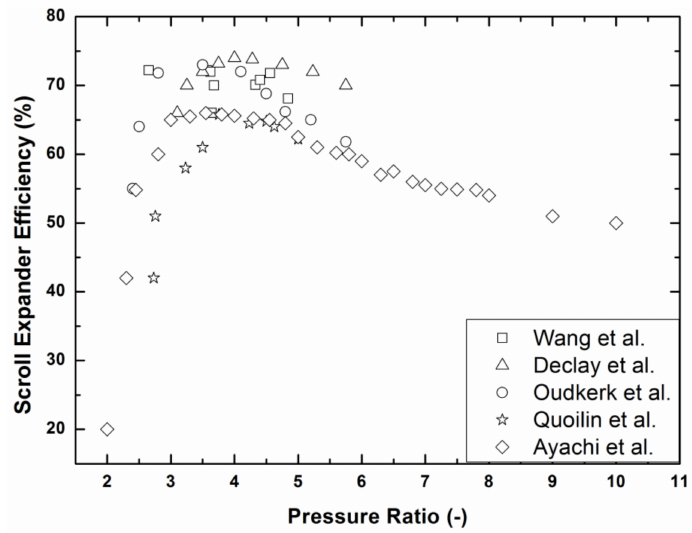
Figure 5. Performance of scroll expander.